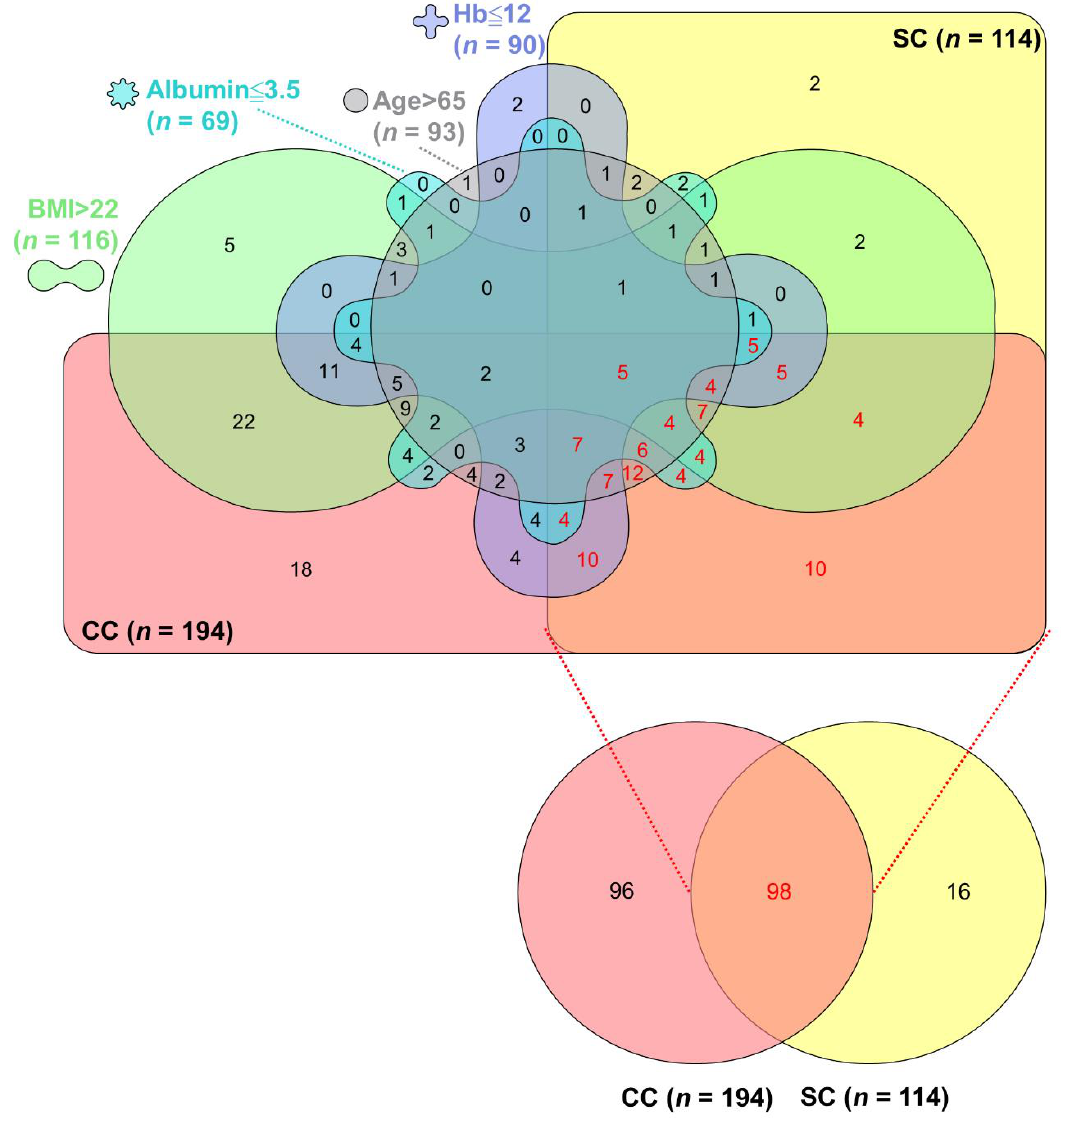
Figure 5. Overlap of six parameters including cancer cachexia presence, sarcopenia presence, older age, high BMI values, and low levels of hemoglobin or albumin in pancreatic cancer patients. The unique overlapping among positive cancer cachexia status (red), positive sarcopenia status (yellow), age > 65 years (gray), BMI > 22 kg/m 2 (green), hemoglobin ≤ 12 g/dL (purple) and albumin ≤ 3.5 g/dL (blue) is illustrated in a Venn diagram. Concurrent CC and SC is shown in orange. The number in each section represents the number of cases, of which the number labeled in red indicates the cases categorized in the CC and SC co-presence group. CC, cancer cachexia; SC, sarcopenia; BMI, body mass index; Hb,